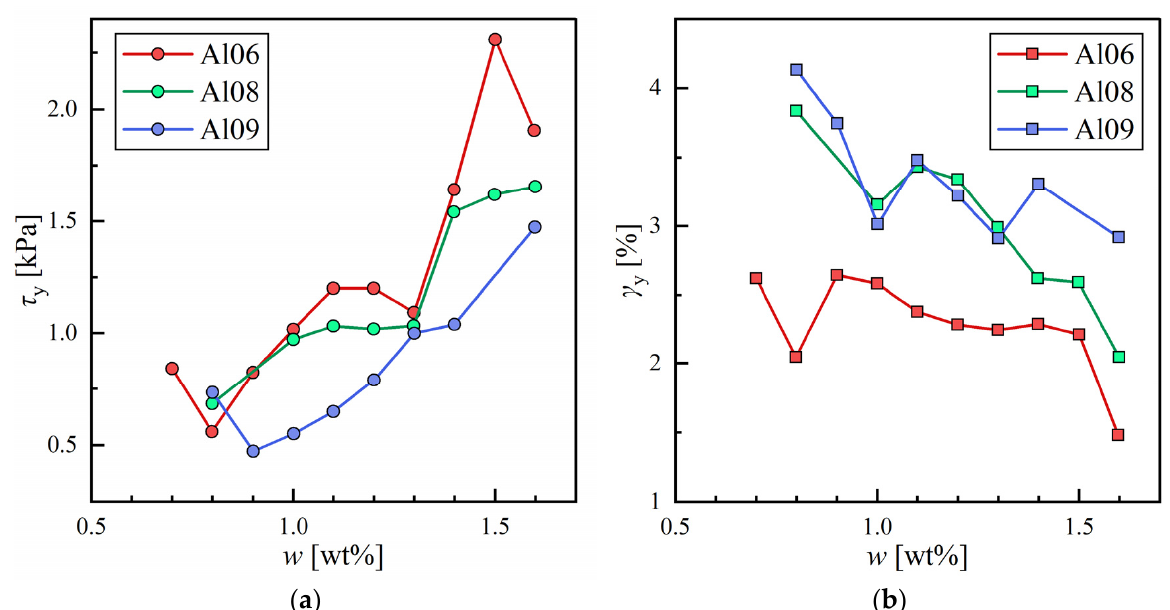
Figure 3. The obtained rheological property of 12HSA organogels prepared with hexane (Al06), octane (Al08), and nonane (Al09): ( a ) Yield stress ( τ y ) with a weight fraction of 12HSA; ( b ) Yield strain ( γ y ) with a weight fraction of